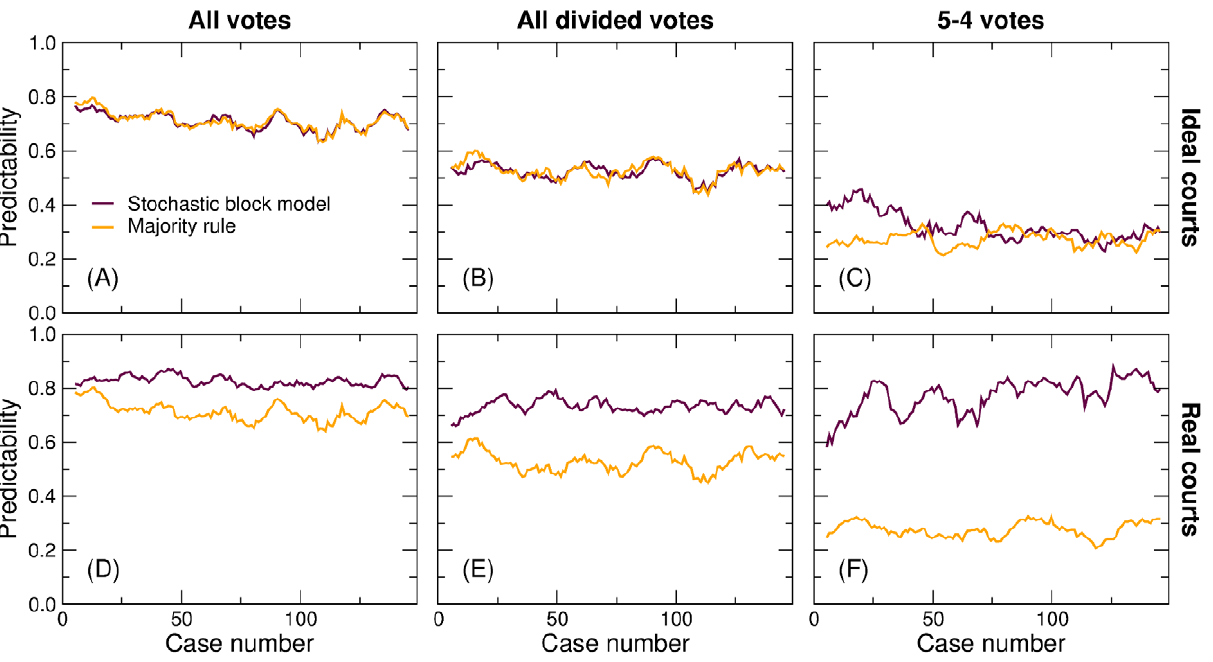
Figure 2. Average predictability of U.S. Supreme Court votes as a function of the case number (first decision of the court, second decision of the court, and so on; see Methods for the definition of predictability). Lines represent the moving average (with a window of + 5 cases) of the average over courts for: (A–C) Ideal courts; (D–F) Real courts. (A, D) Predictability considering all decisions; (B, E) excluding unanimous and 8–1 decisions; (C, F) considering only 5–4